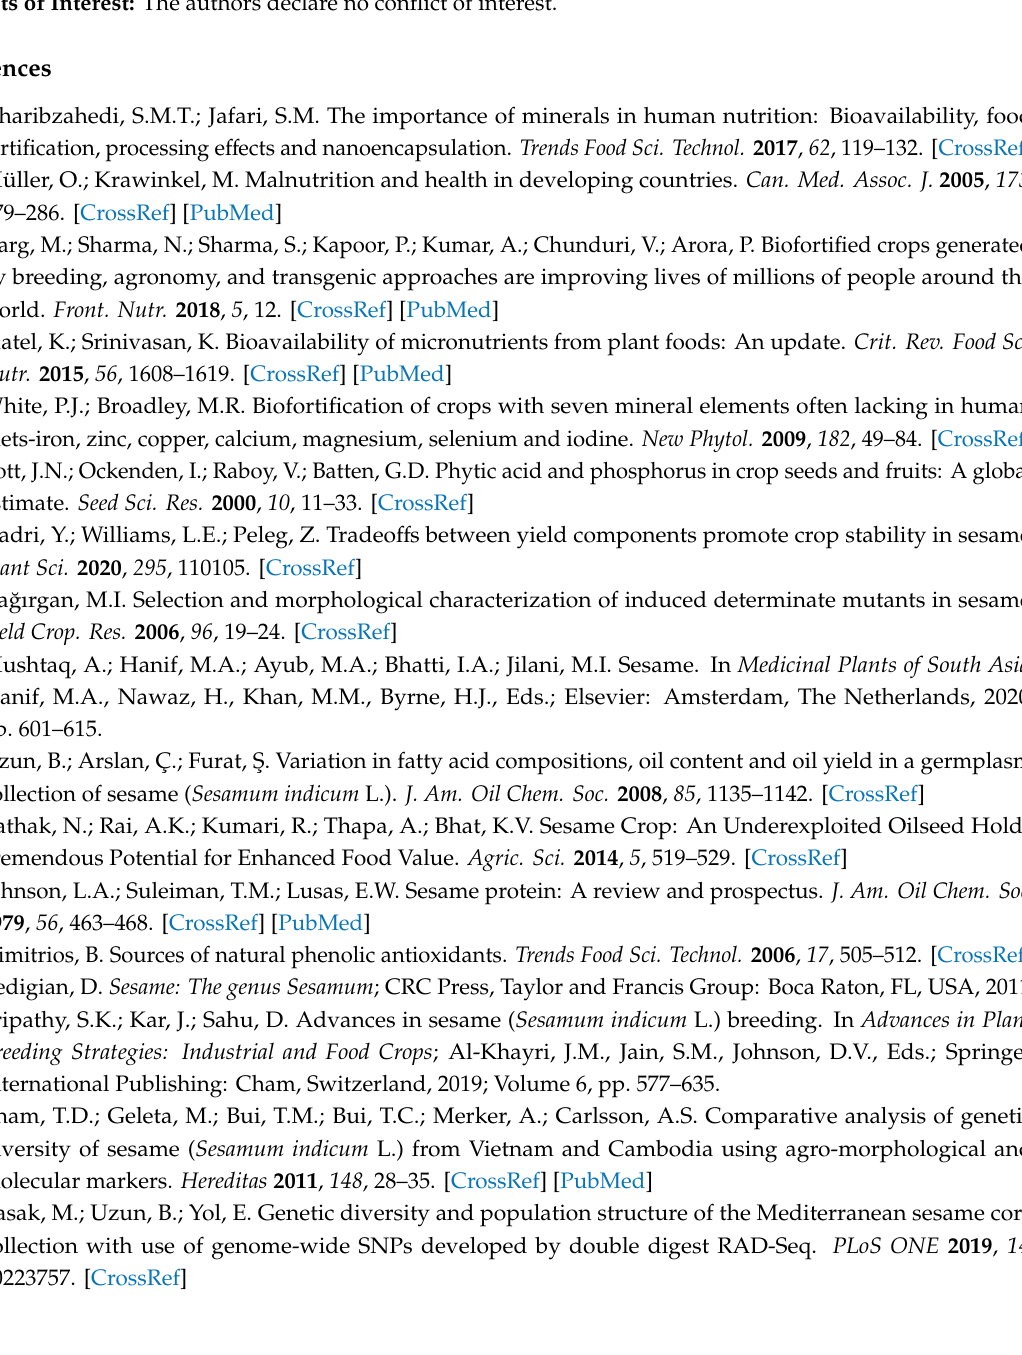
bin markers, Table S7: Quantitative trait loci for plant phenological, morphological and seed quality traits, Table S8: Genes found within selected multi-traits QTL intervals, Table S9: Putative candidate genes selected from multi-traits QTL intervals, Table S10: Iron bio-accessibility in di ff erent food sources, Table S11: Mineral-nutrient bio-accessibility of sesame seed paste in the